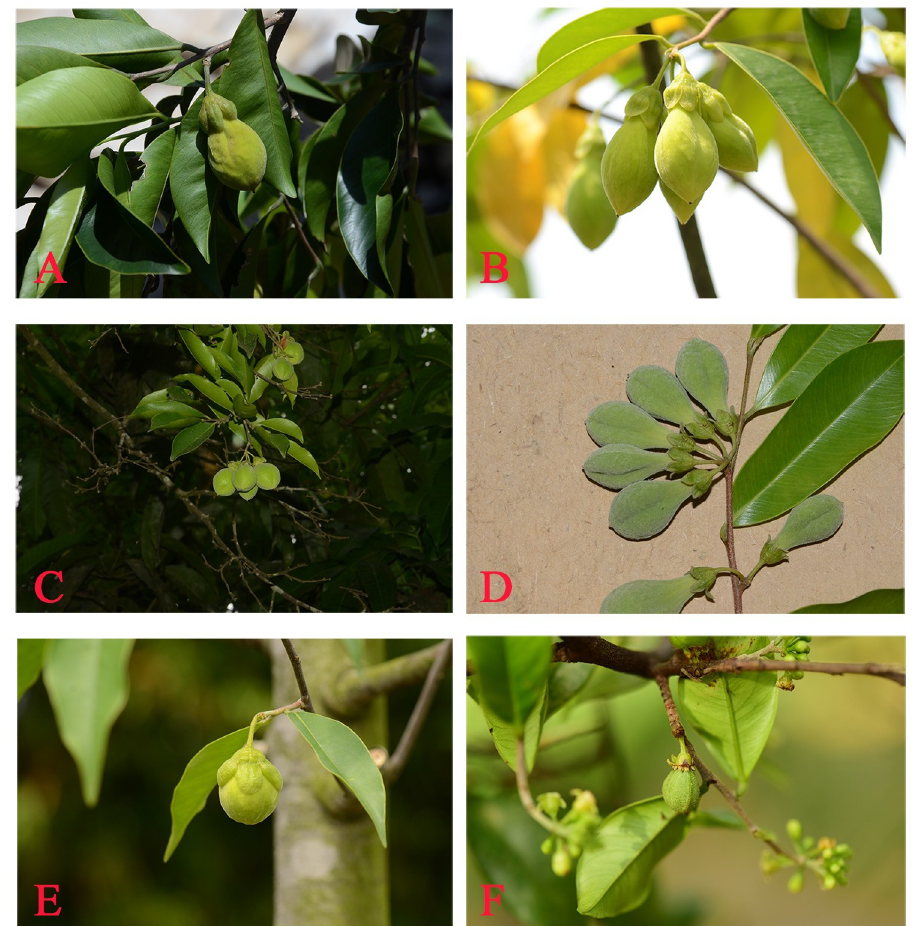
Fig 2. Fruits of Qi-Nan germplasm and five accurately identified Aquilaria species. A: Qi-Nan germplasm. B: A .